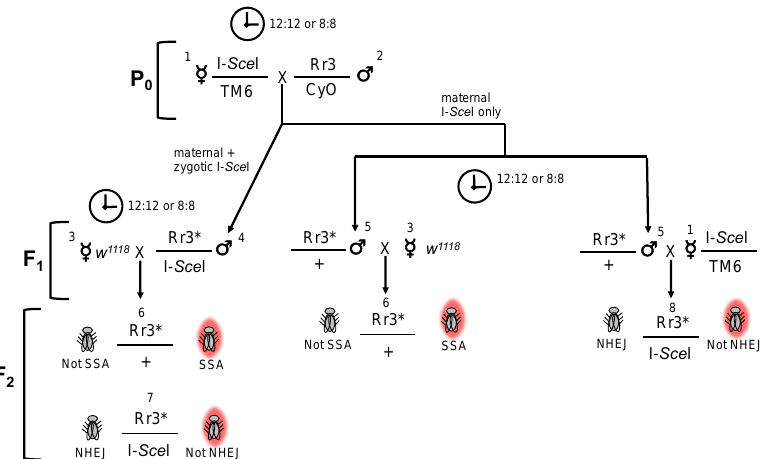
Figure 1. Multi-generational cross scheme used to assess the effect of non-24 h L:D schedule on relative use of SSA and NHEJ repair in the male pre-meiotic germline. Asterisk indicates an Rr3 construct that has been exposed to I- Sce I endonuclease. Full genotypes of numbered flies are indicated in Table 1 below. Table 1. Full genotypes of flies described in Figure 1a. P{UIE} is an abbreviation for P{Ubiq::I-SceI} . Details of the construction of the Rr3 and P{UIE} constructs are given in [36].